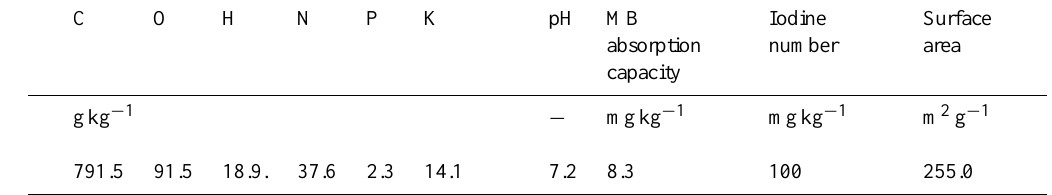
Table 1. Chemical and physical property of hardwood biochar (from broad-leaved tree ( Quercus serrata Murray)).